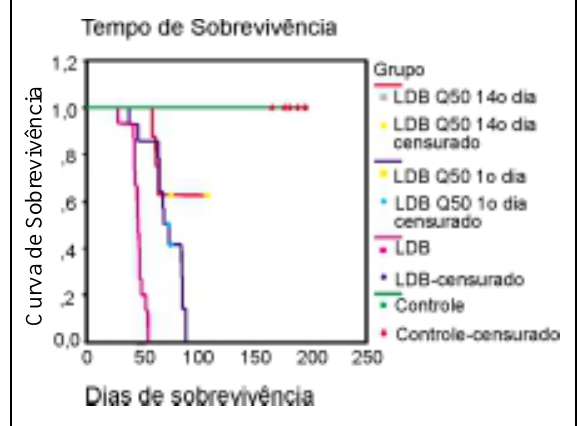
FIGURA 2 - Gráfico demonstrando a curva de sobrevivência, Teste Kaplan- Meier.